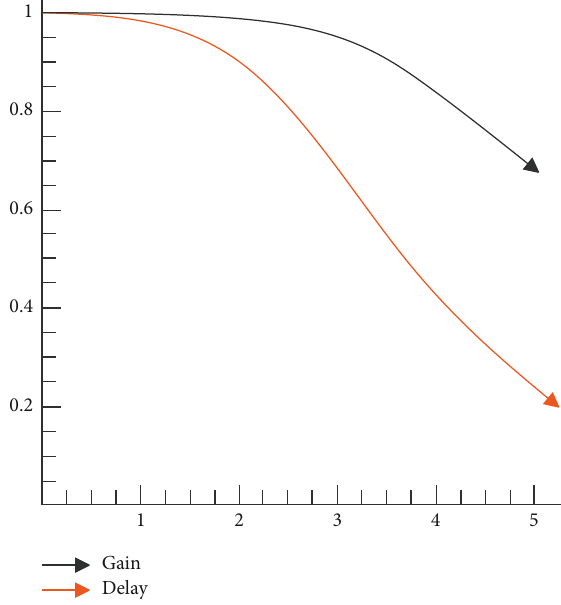
Figure 8: Schematic diagram of gain attenuation and group delay of 4th-order Bessel